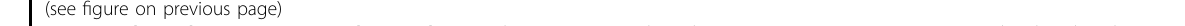
Fig. 2 Study A: glutamate associated networks. A Higher anterior cingulate glutamate concentrations are associated with reduced connectivity across a range of NBS thresholds. The horizontal red line represents the p < 0.05 threshold while the blue line represents statistical signi fi cance across a range of thresholds. B Illustration of glutamate-connectivity relationship at a single threshold. Mean connectivity within the glutamate associated network for the NBS threshold of t = 2.5 is negatively associated with glutamate concentrations. C Mean connectivity within the glutamate associated network was positively associated with MATRICS reasoning scores in patients ( r s = 0.25, p = 0.04, df = 75), and the sample as a whole ( r s = 0.17, p = 0.04, df = 157). D The glutamate associated network for the threshold t = 2.5. Only intra canonical network edges are shown, intra salience network edges are show in red, while all other networks are shown in blue. A relative excess of salience network edges is apparent. E Heatmap illustrating the proportion of canonical intra- (diagonal) and inter-(off diagonal) network edges that overlap with the glutamate associated network. A normalised proportion of edges greater than one indicates a relative excess of edges compared to what would be expected to an even distribution of edges across the cortex. Salience network edges show greater overlap with the glutamate associated network than other canonical networks. F Results of permutation testing show that the excess of salience overlapping edges within the glutamate associated network is statistically signi fi cant across a range of NBS thresholds. The horizontal red line represents a threshold of p < 0.05, while the other lines represent the statistical signi fi cance of the overlap between a canonical network and the glutamate associated network. Only the salience network is signi fi cantly overrepresented, and this is at all thresholds. AUD auditory, DAT dorsal attention, DMN default mode, FPN frontoparietal, SAL salience, SMN Sensorimotor, VAT ventral attention, VIS